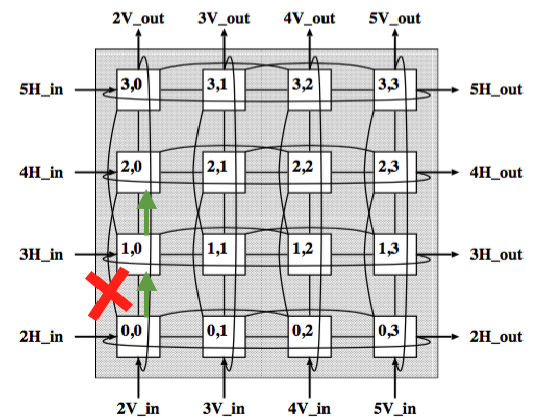
Figure 3. Link failure at BM Level. There is a fault between the Node(0,0) and Node(1,0), preventing direct commute between them.